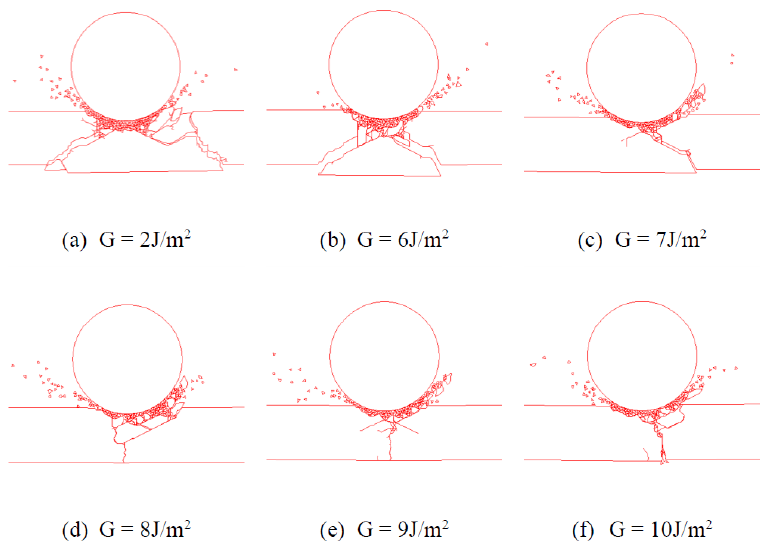
Figure 22. Fracture patterns of the glass with α = 90°, v = 5 m/s and different G at t = 1 ms. Table 8. Impact failure modes at v = 5 m/s with different fracture energies of glass.